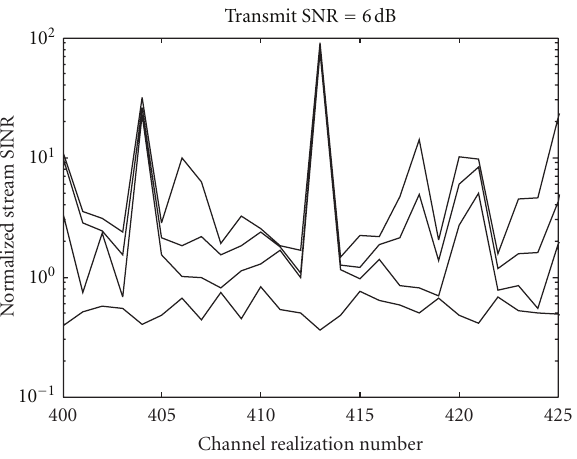
Figure 6: Eight-antenna example. Typical example of how the fix works.